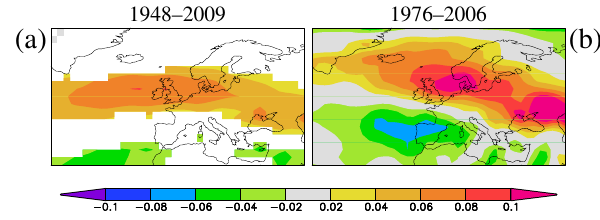
Fig. 16. Trends in January–March zonal geostrophic wind U [ms − 1 yr − 1 ] over 1948–2009 (a) and 1976–2006 (b) . In (a) only grid boxes with p< 0.1 are shown.